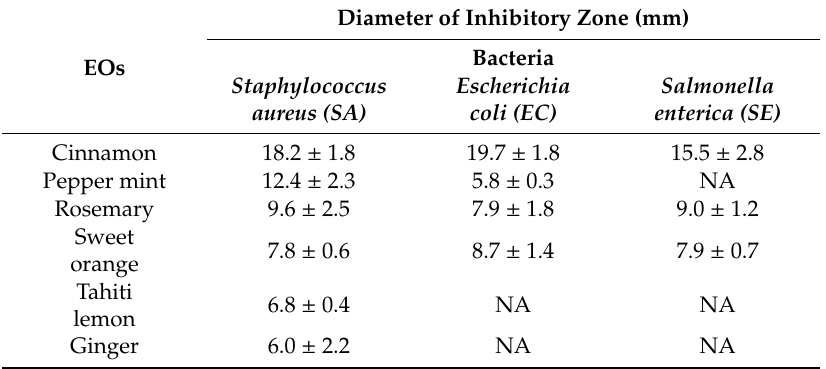
Table 1. Antimicrobial activity of EOs by disc di ff usion assay [60].